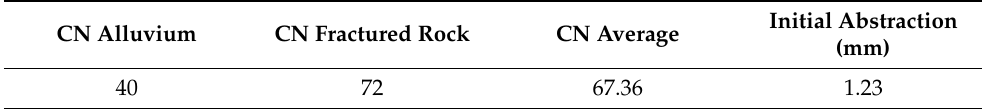
Table 5. Predicted CN value in Al-Lusub